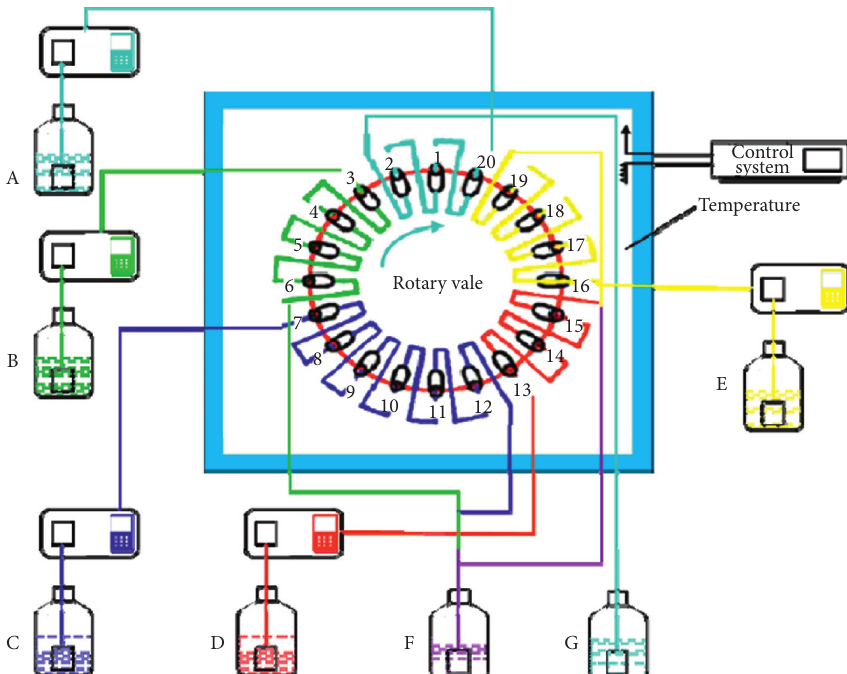
Figure 1: The assembly diagram of the SMB system for purification of BKBA. Note: A: desorbing solution (40% ethanol), B: refined solution (20% ethanol), C: adsorption solution (raw anthocyanin solution), D: water washing solution (deionized water), E: regenerative solution (80% ethanol), F: waste water, and G: refined